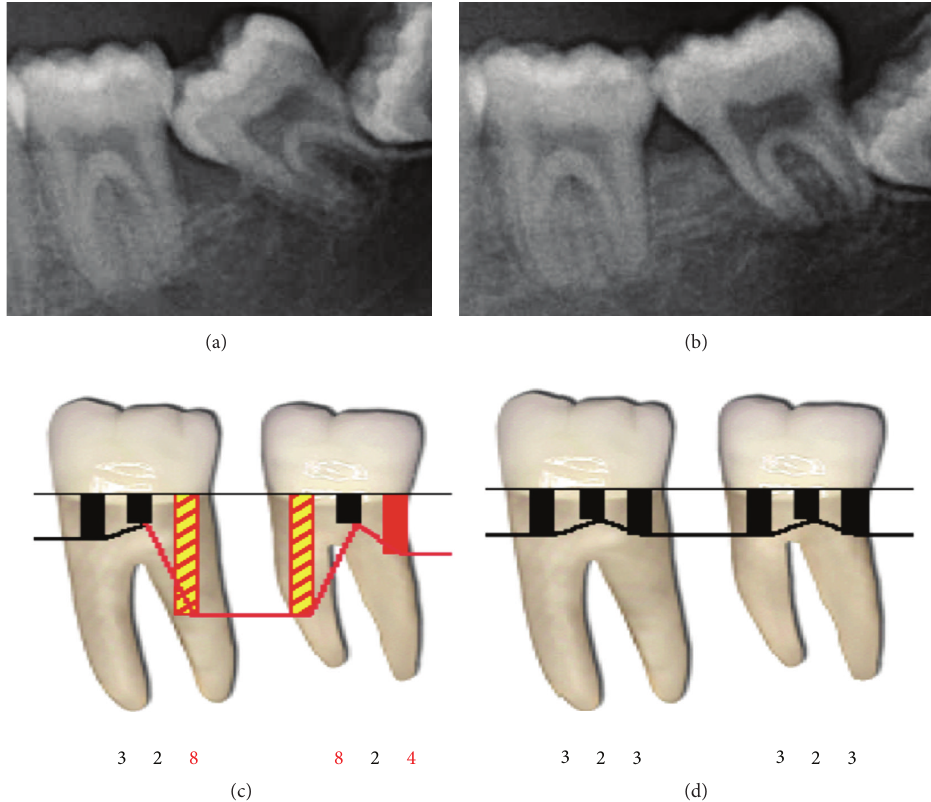
Figure 4: (a) Radiographic view of pretreatment, (b) radiographic view of third month after the treatment, (c) probing pocket depth values of pretreatment, (d) probing pocket depth values after the